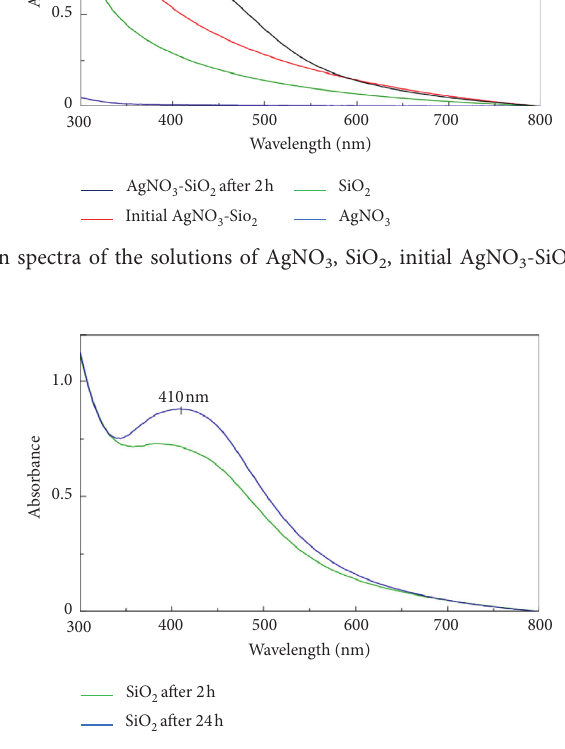
Figure 2: UV-vis absorption spectra of the solution AgNO